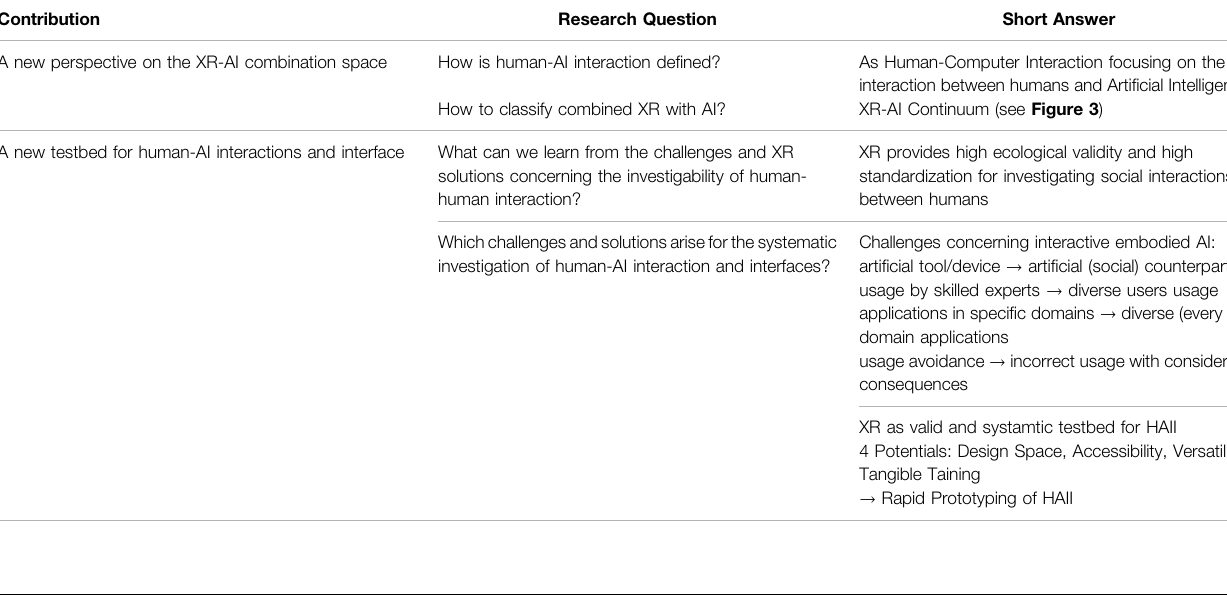
TABLE 6 | summarizes the results of the article ’ s fi rst